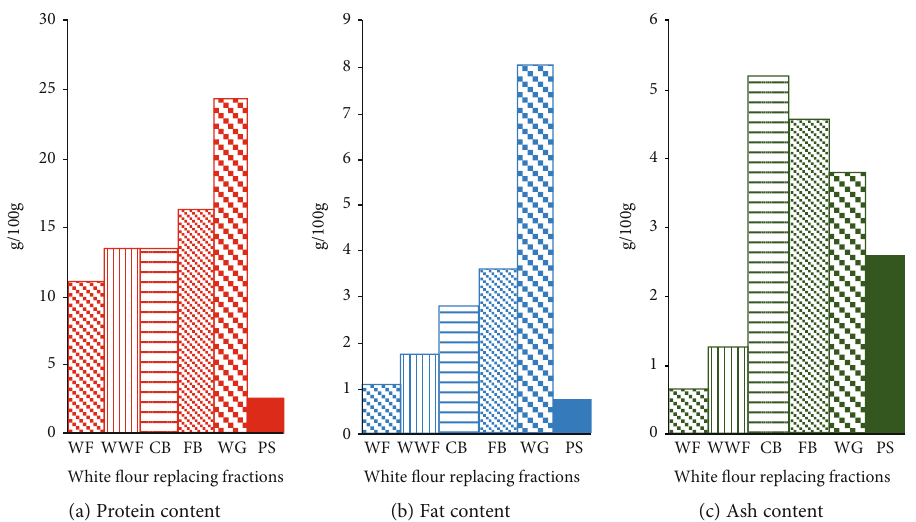
Figure 1: Protein, fat, and ash content of various fractions of wheat compared with the psyllium husk. Legend: WF: white fl our; WWF: whole wheat fl our; CB: coarse bran; FB: fi ne bran; WG: wheat germ; PS: psyllium husk. Table 1: Farinograph characteristics of dough made from fl our, bran fractions, and germ blends. Sample code